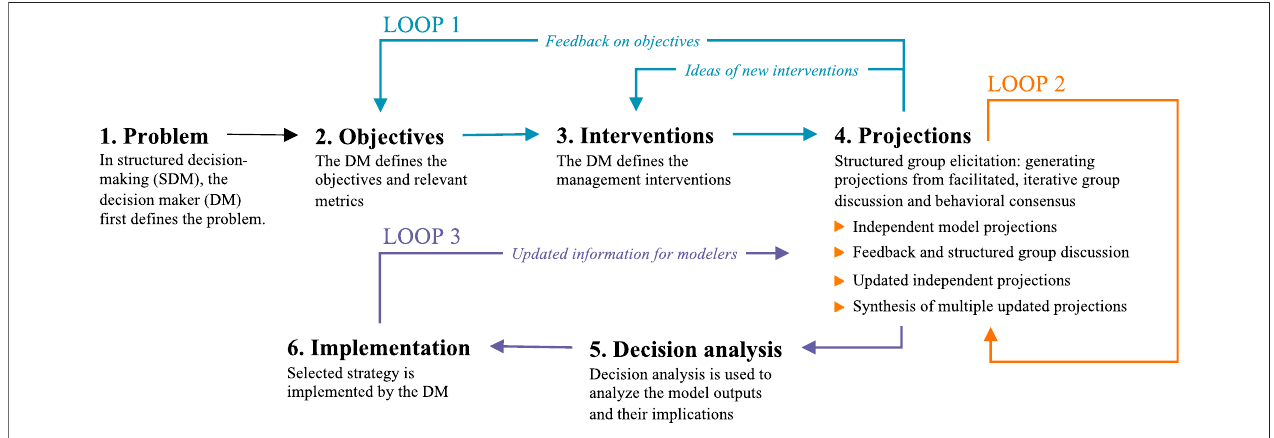
FIGURE 4 | Redrawn from Shea et al. ’ s [56] structured process for obtaining, revising and implementing a diverse set of mathematical models for a common